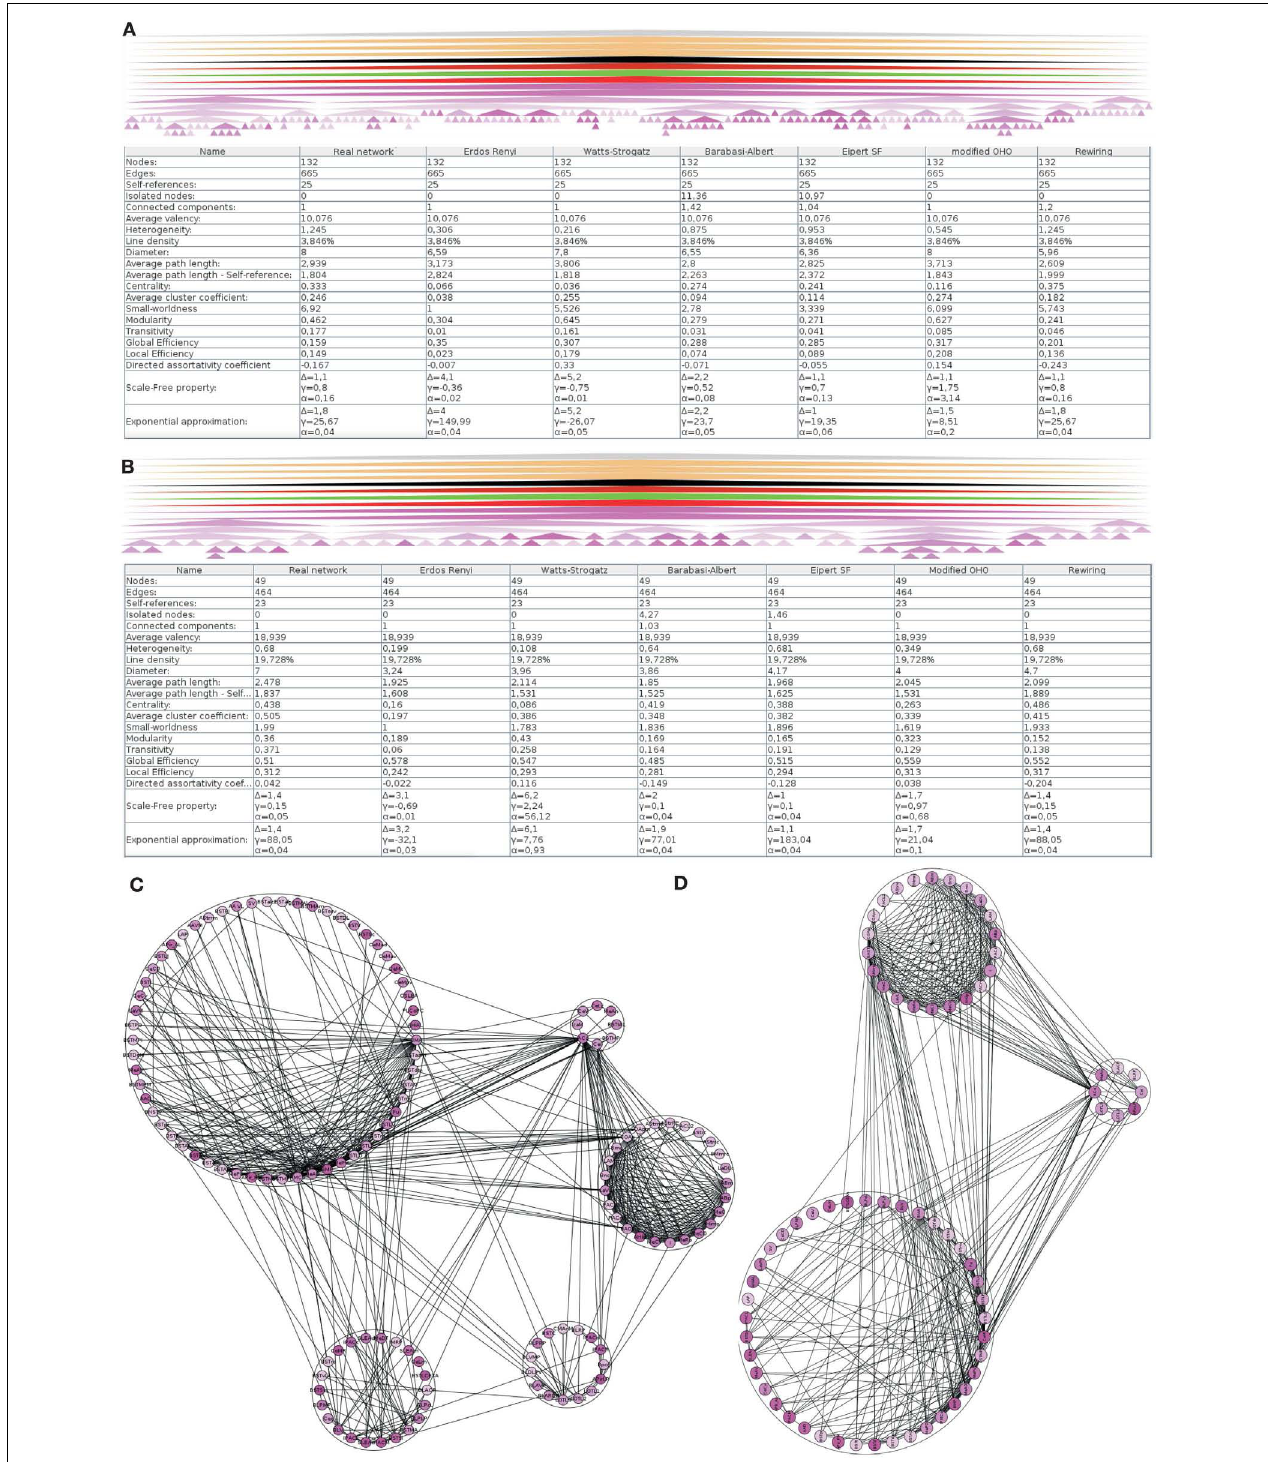
1000 times by 6 different network generators and global parameters of 1000 simulations were averaged.The result of a modularity analysis is shown in (C) (all regions) and (D) (regions with at least one input and output). (C) Within the 5 modules the number of connections is larger than in between the modules. (D) The number of modules is reduced to 3 if only those regions are considered that have at least one input and one output (90˚ rotated